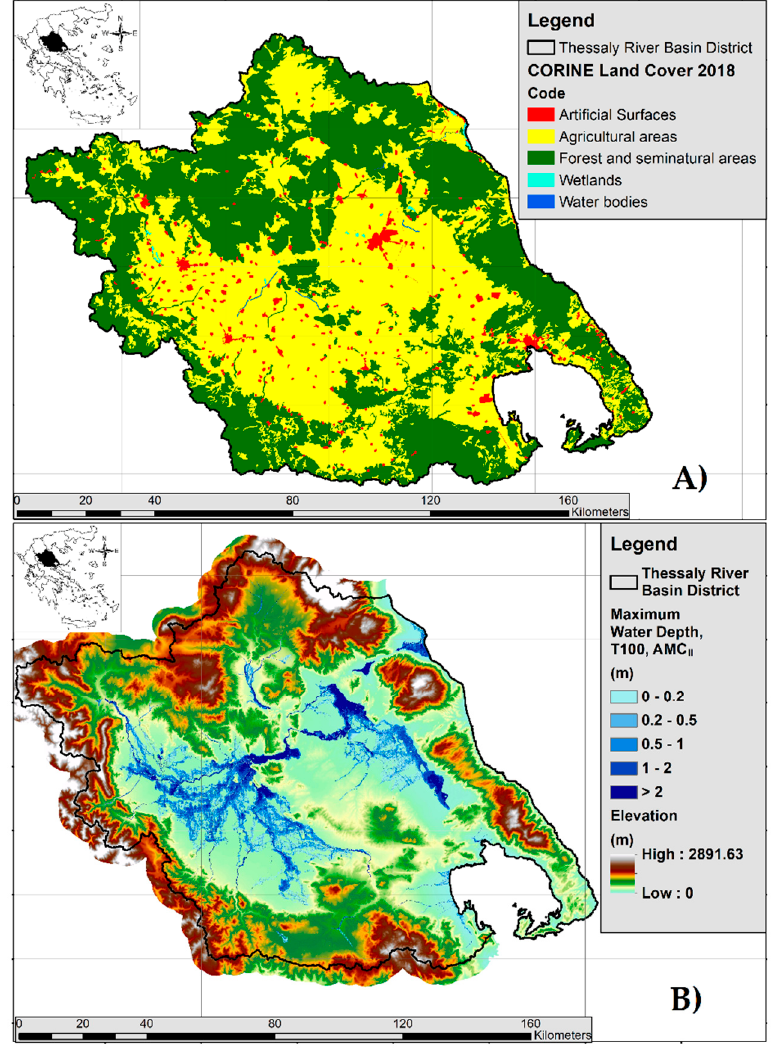
Figure 1. ( A ) The Basin District of Thessaly, with the mainland uses according to the Corine Land Cover (2018), ( B ) Indicative results of 2-D flood (T = 100) simulations for Thessaly (Adapted from [27]).